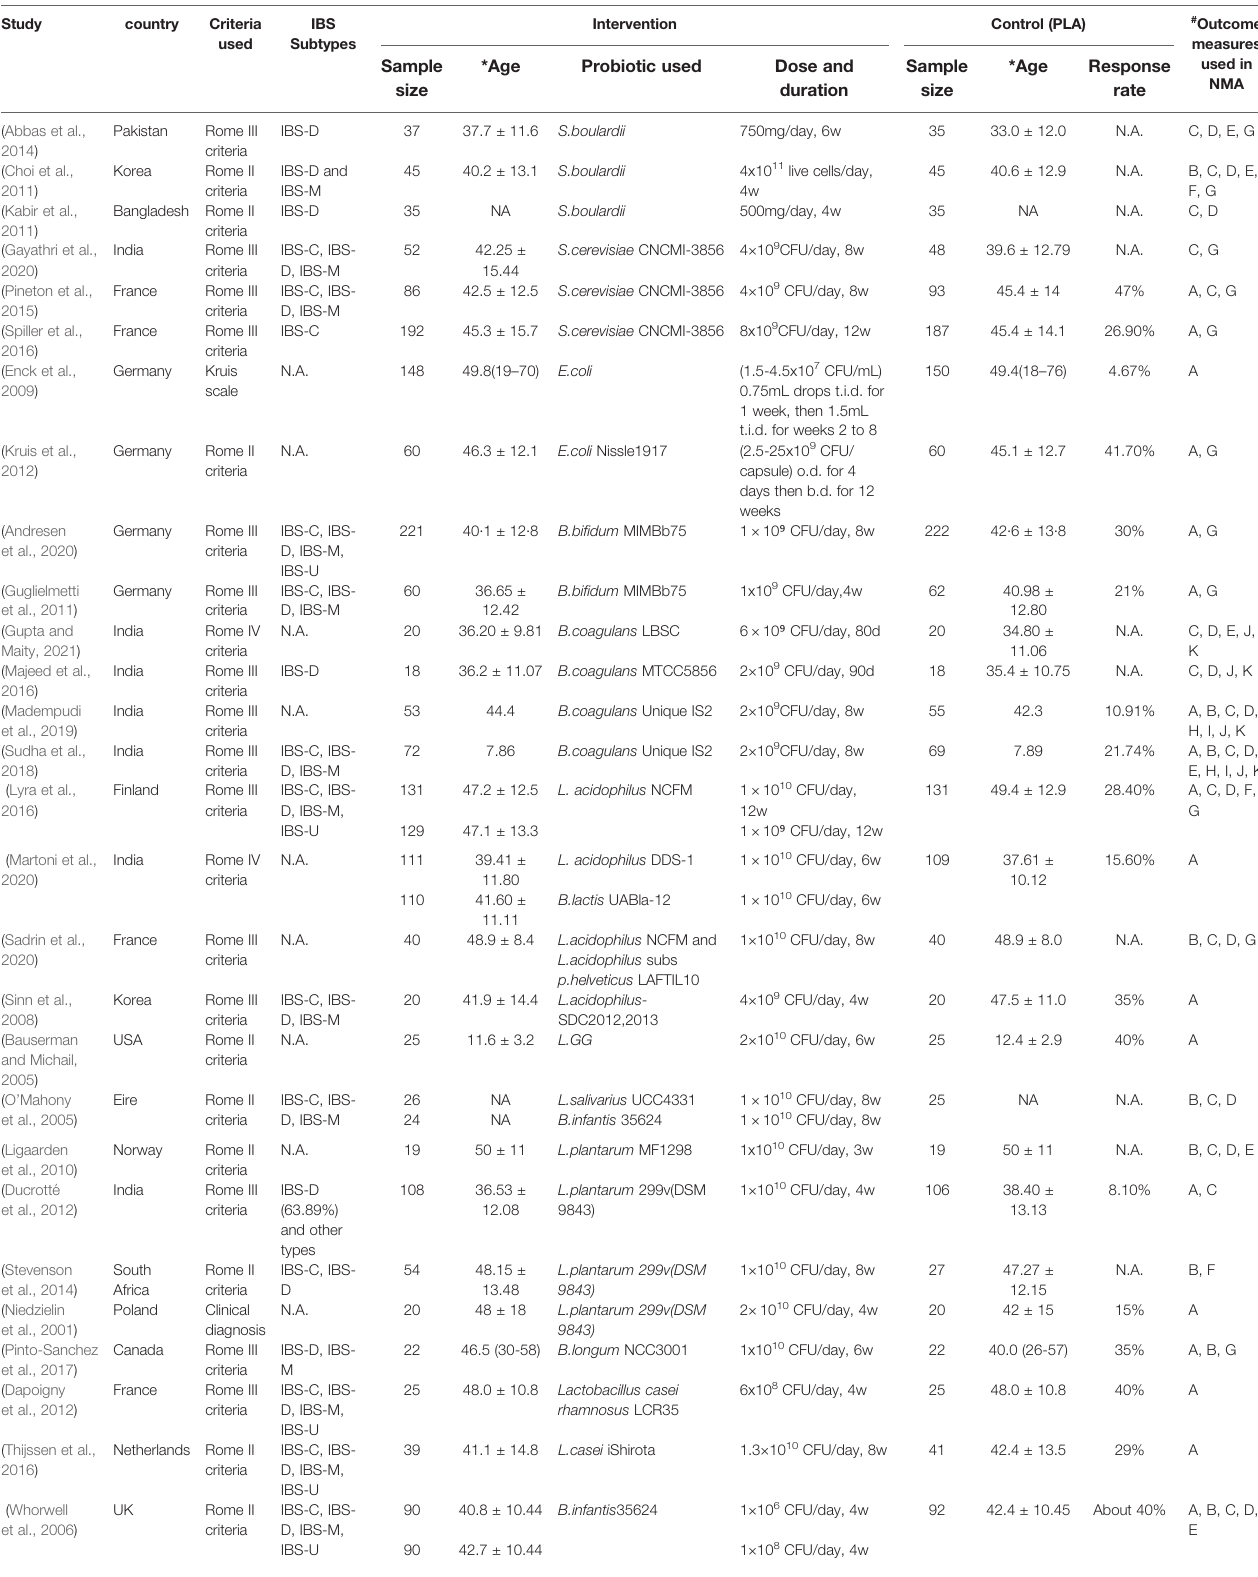
TABLE 1 | Characteristics of RCTs about the ef fi cacy of probiotics in irritable bowel syndrome.